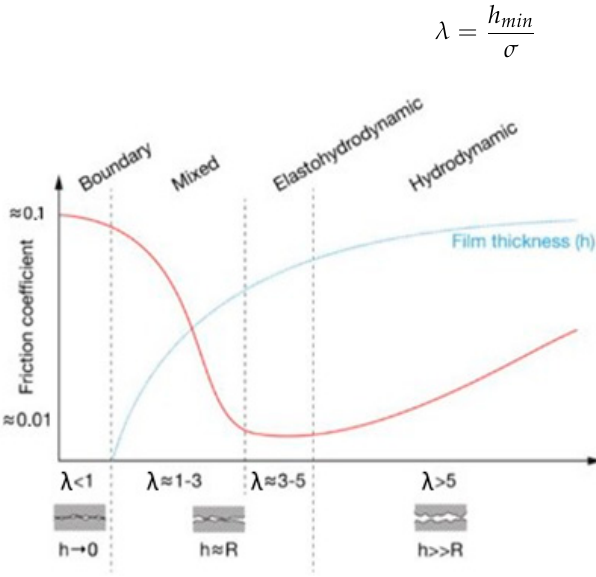
Figure 8. Stribeck curve and lubrication regime analysis.